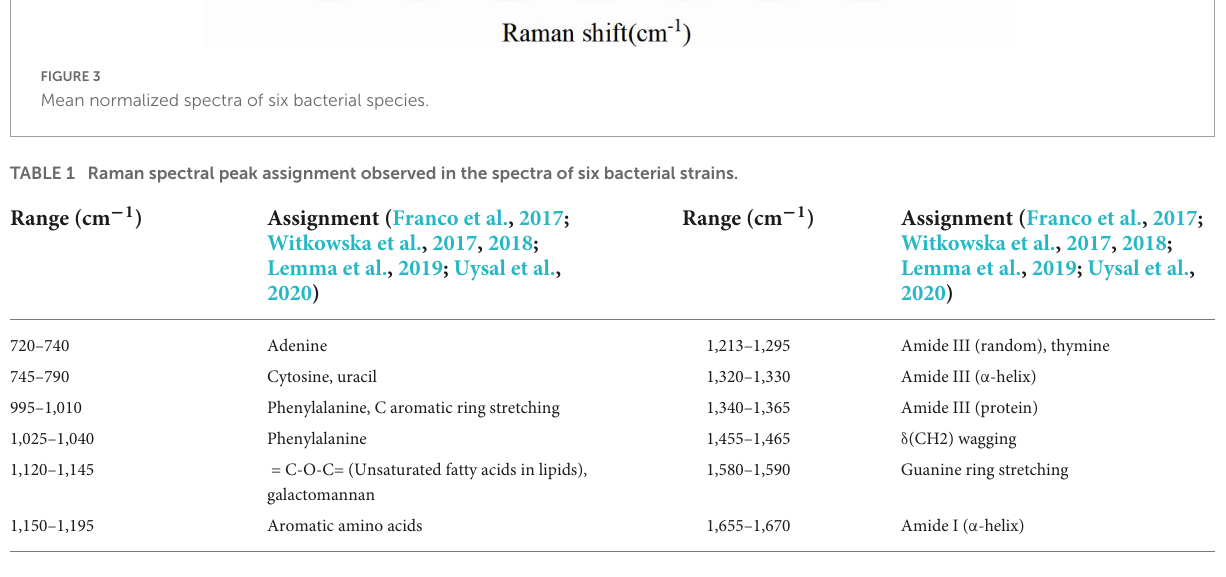
TABLE 2 Intensity and intensity ratio of some peaks between C. botulinum and S.